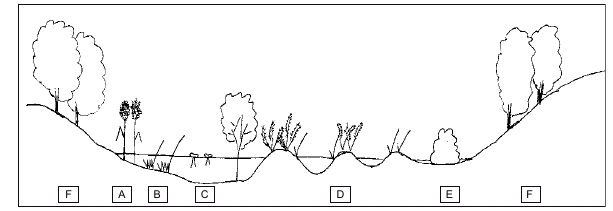
Fig. 4. Transect of actual vegetation around Lago